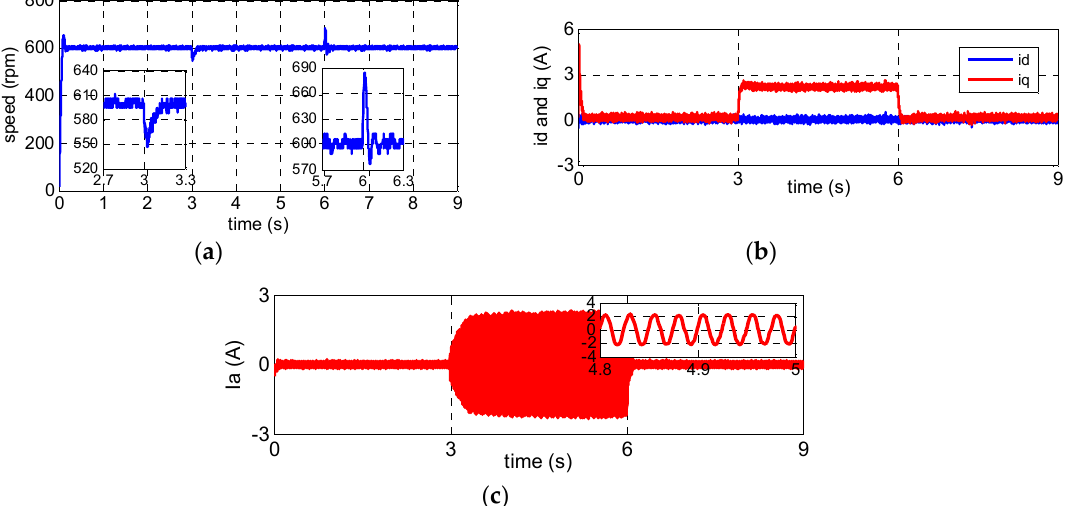
Figure 17. Experimental curves of rotor speed with a step disturbance of 1 N ∙ m under the PI method: ( a ) Rotor speed responses; ( b ) curves of stator currents in the dq -axis; ( c ) curves of a-phase stator current.